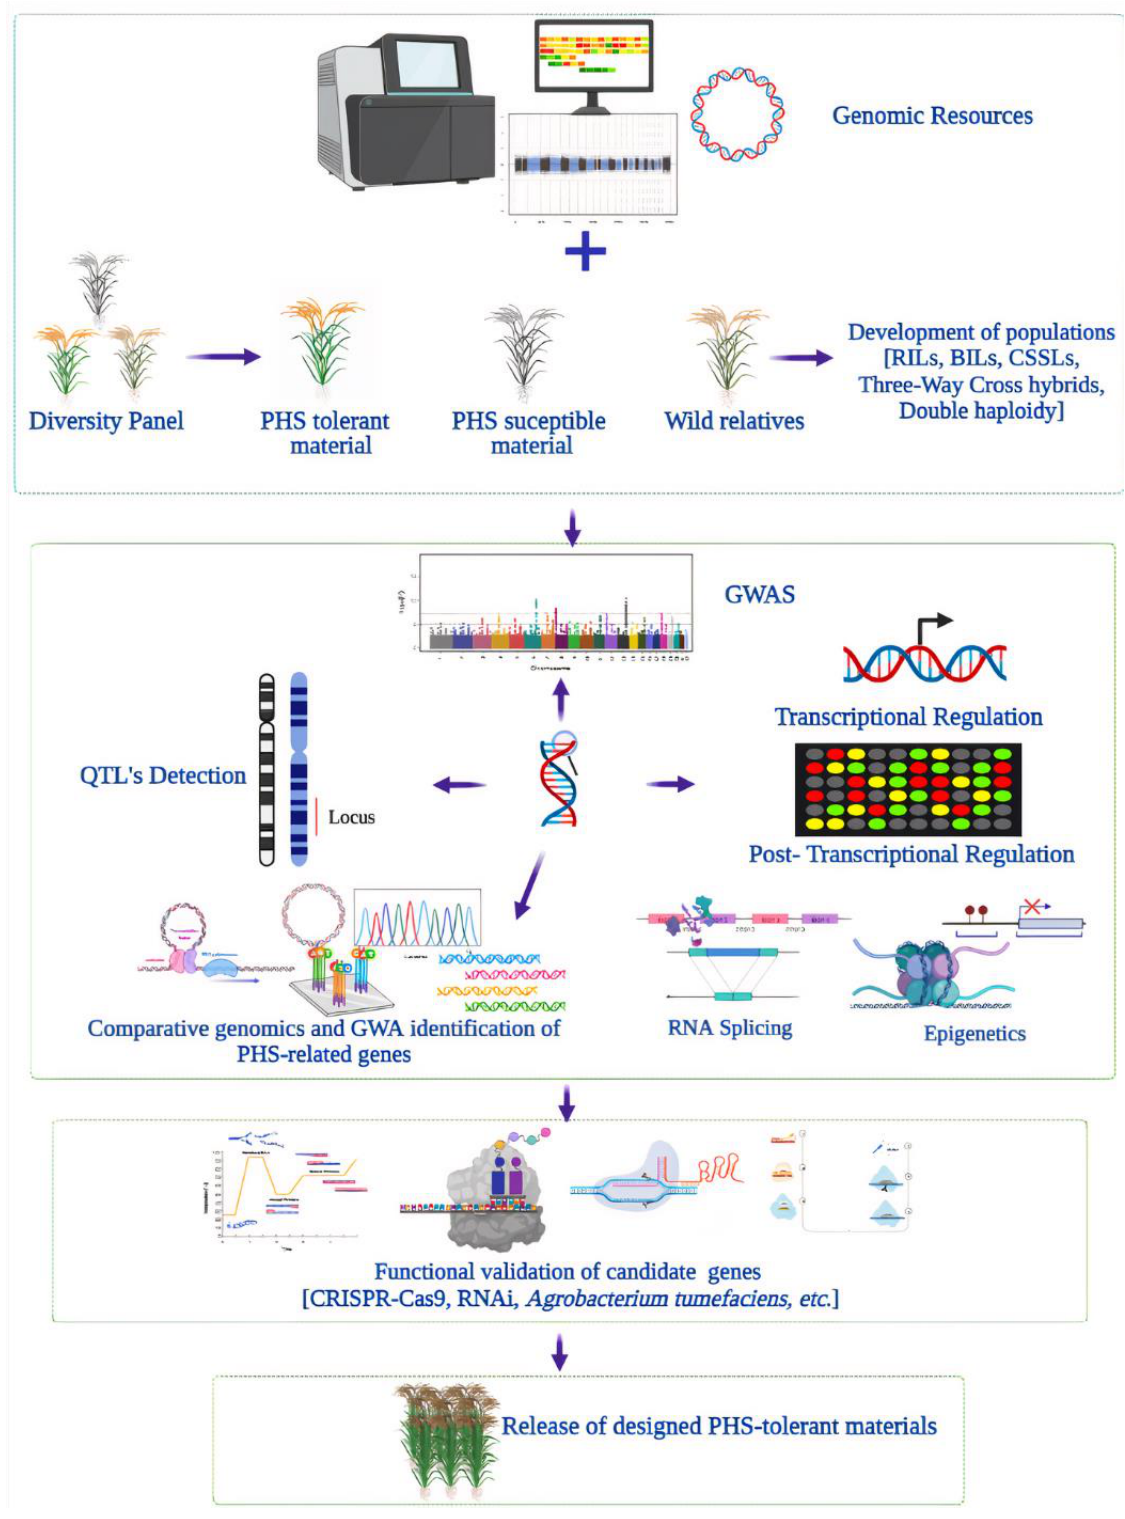
Figure 2. Omics-based approaches for the production of pre-harvest sprouting-resistant rice varieties. Applications of genomic selection (GS) such as estimating breeding values, developing improved models for prediction of parent and variety selection, as well as using genome-wide association studies (GWASs), marker-assisted selection (MAS), QTL studies, recombinant inbred lines (RILs), backcross inbred lines (BILs), chromosome segment substation lines (CSSLs), three-way cross hybridization, and double haploidy (DH) toward accelerated breeding.